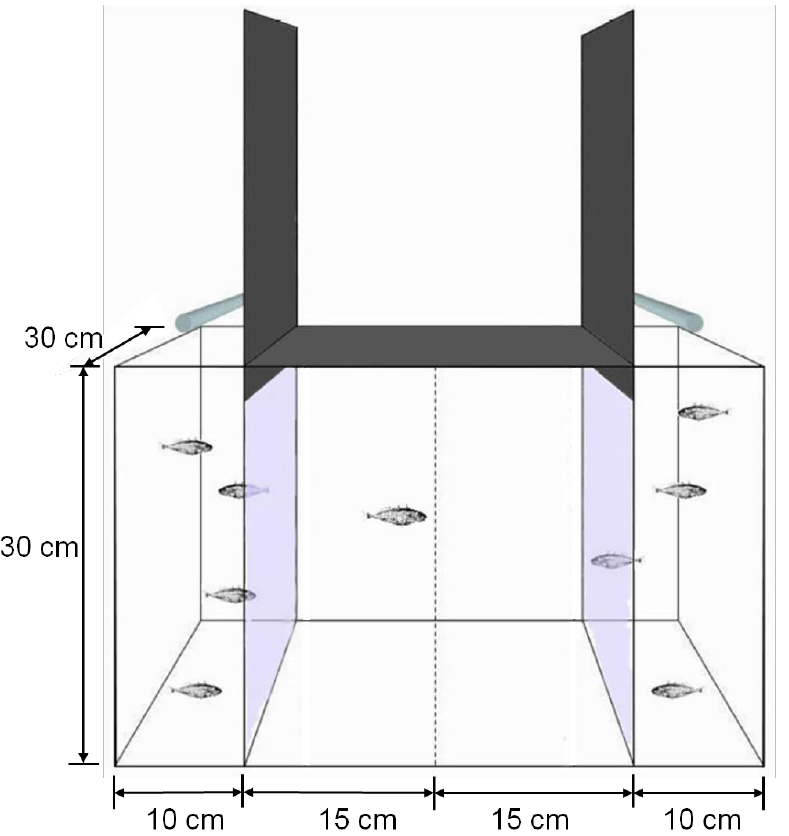
Figure 2 . The test aquarium used to measure shoaling and habitat preferences. The aquarium was divided into three compartments by olfactory-proof fixed UV+ Plexiglas partitions. In the left and right shoal compartments, we placed two shoals of each four size-matched fish in the shoal choice tests and no fish in the habitat choice tests. The test fish, which was either raised under UV+ or UV- condition, was placed in the middle section. Between the compartments there were optical ultraviolet or neutral density filters (UV+, UV-, ND1 or ND2) and an opaque partition. Filters and the opaque partition could be lifted from a distance by a rope. In the Figure, the opaque partitions had been lifted. In front of the aquarium, a webcam recorded fish movements. The line drawn on the front and back pane visually divided the choice arena into two equal halves. Indicated are the fluorescent tubes installed above the shoal compartments. The choice arena was covered on top by an opaque gray